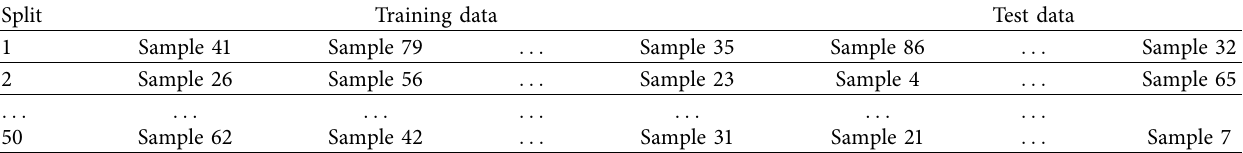
Table 5: An example of manual cross-validation between training and test